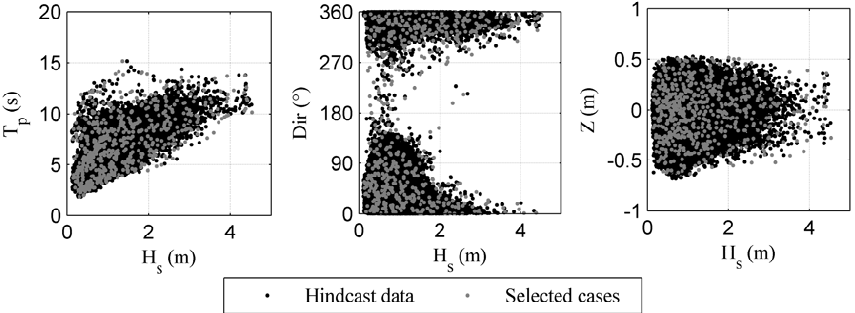
Figure 4. Significant wave height ( H s ) against wave period ( T p ) and mean direction corresponding to the 30-year wave hindcast data, and astronomical tide ( Z ), showing the distribution of the selected cases using the MDA algorithm for M = 600.